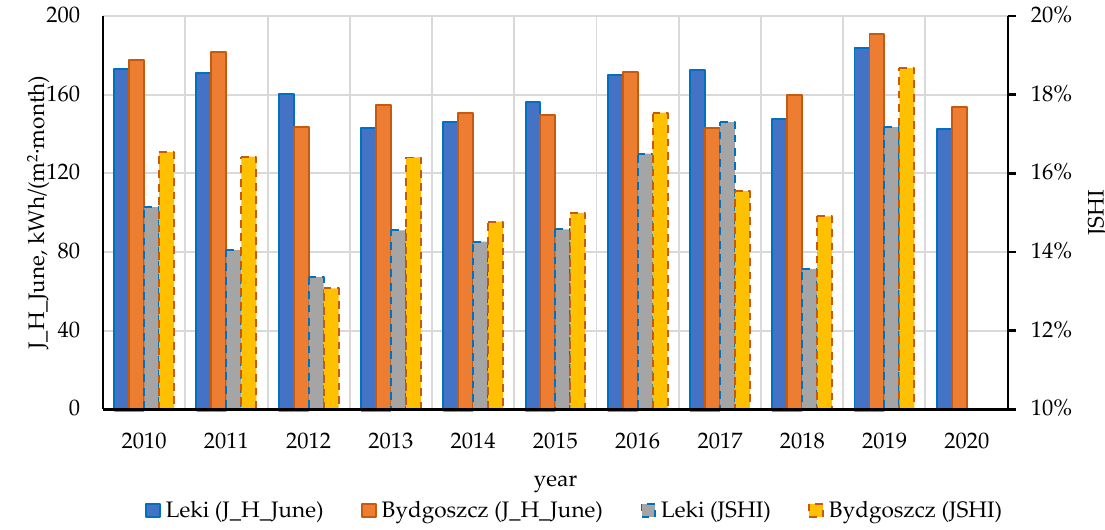
Figure 13. Comparison of insolation values varied from locations for June in the last 11 years. Source own study based on [18,33,57].